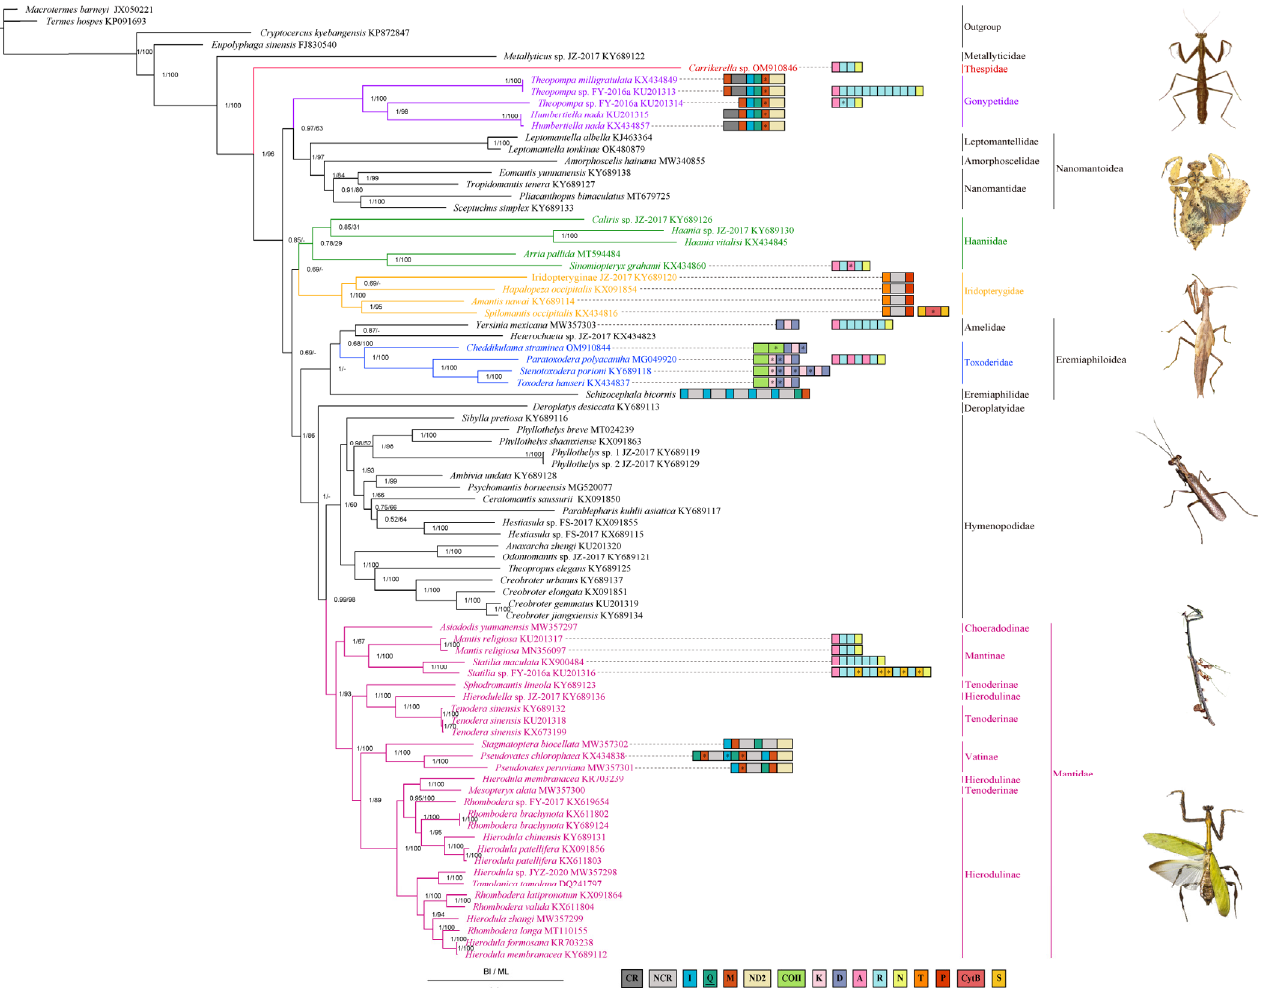
Figure 4. Phylogenetic tree of the relationships among 82 species of Mantodea based on the nucleotide dataset of the 13 mitochondrial protein-coding genes via BI and ML methods. Two cockroaches ( Eupolyphaga sinensis, Cryptocercus kyebangensis ) and two termite ( Termes hospes , Macrotermes barneyi ) species was chosen as the outgroup. The numbers on branches display posterior probabilities (PP) and bootstrap support (BS) as determined from BI (left) and ML (right), respectively. The relevant GenBank accession numbers of all species are displayed in the figure. The size of the genes is not proportional. Box images on the right illustrate gene rearrangements and the location of the NCRs for the praying mantis species covered in this study. Genes with underlines encoded by the N-strand and those without underlines are genes encoded by the J-strand. Asterisked genes indicate pseudogenes. The remaining genes and gene orders that were identical to those of the ancestral insect are